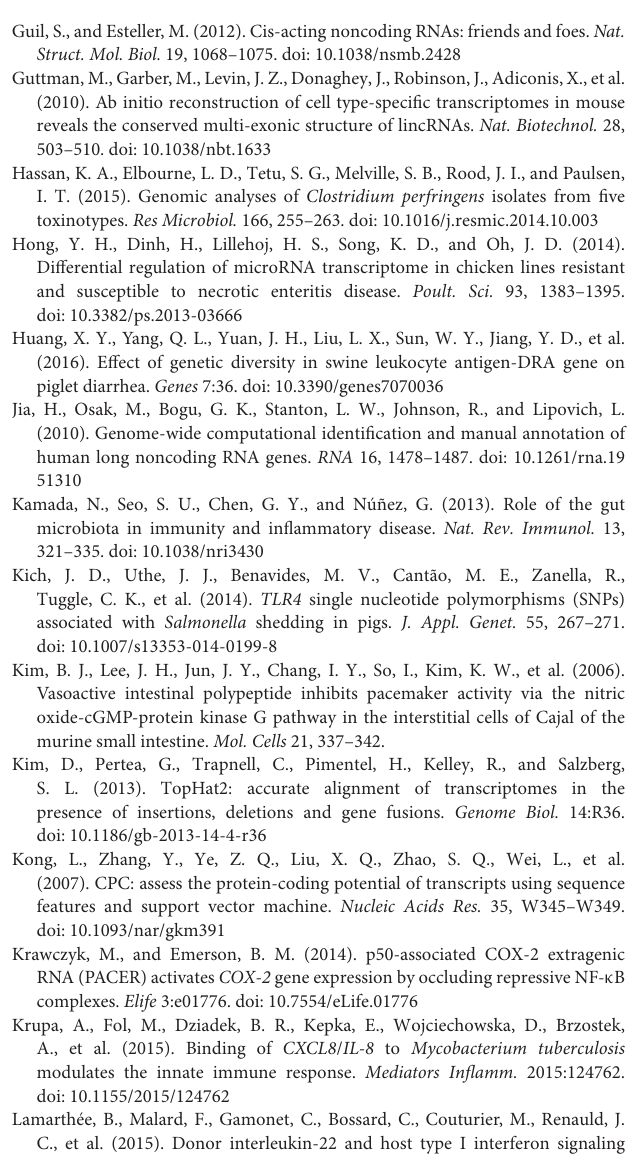
Figure S1 | Screening principles of association analysis between dysregulated lncRNAs and mRNAs. Figure S2 | Identification pipeline for lncRNAs. Each step is described in detail in the methods section. Figure S3 | One thousand eight hundred and fifty non-coding lncRNAs were selected by Cufflinks and